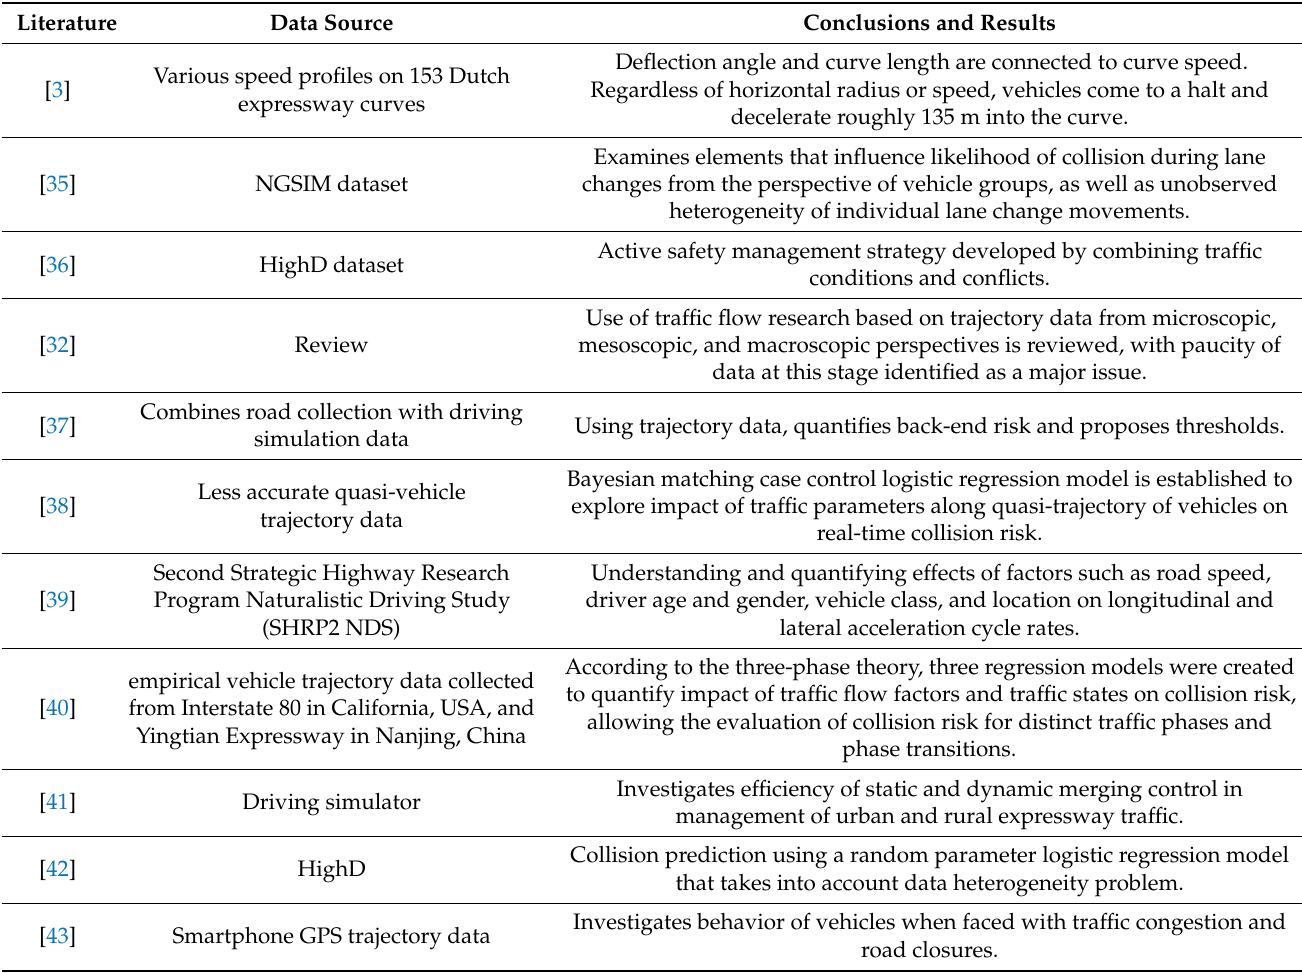
Table 1. Summary of vehicle speed and trajectory data